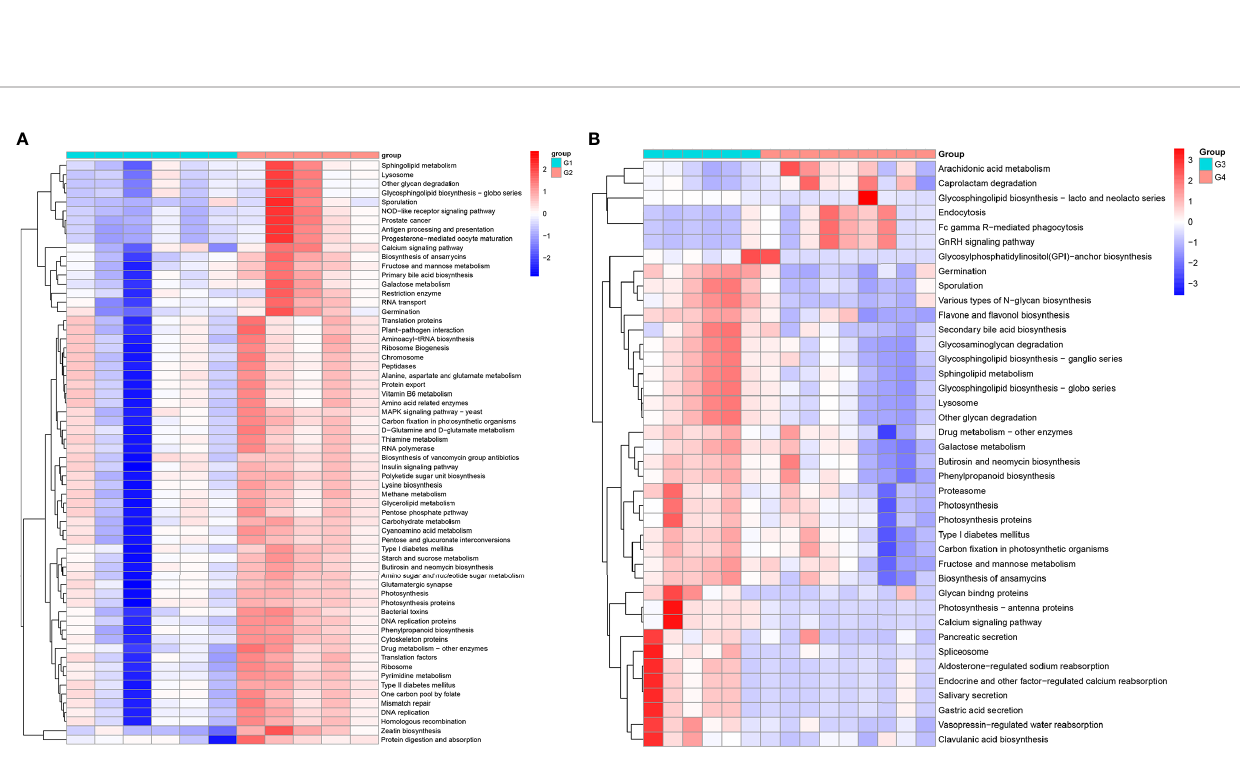
FIGURE 9 | The top 30 differential COG between smokers and non-smokers. (A) Differential COG in healthy men; (B) differential COG in men with BCa.